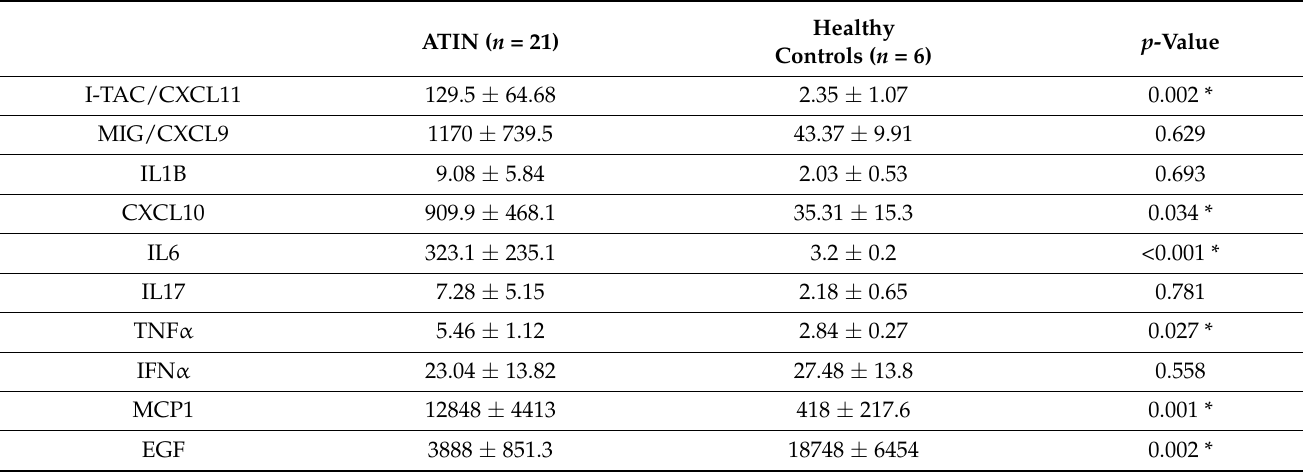
Table 3. Comparison of the urinary concentration of the evaluated cytokines in patients with ATIN and healthy controls. * Statistically significant differences. ATIN—acute tubulointerstitial